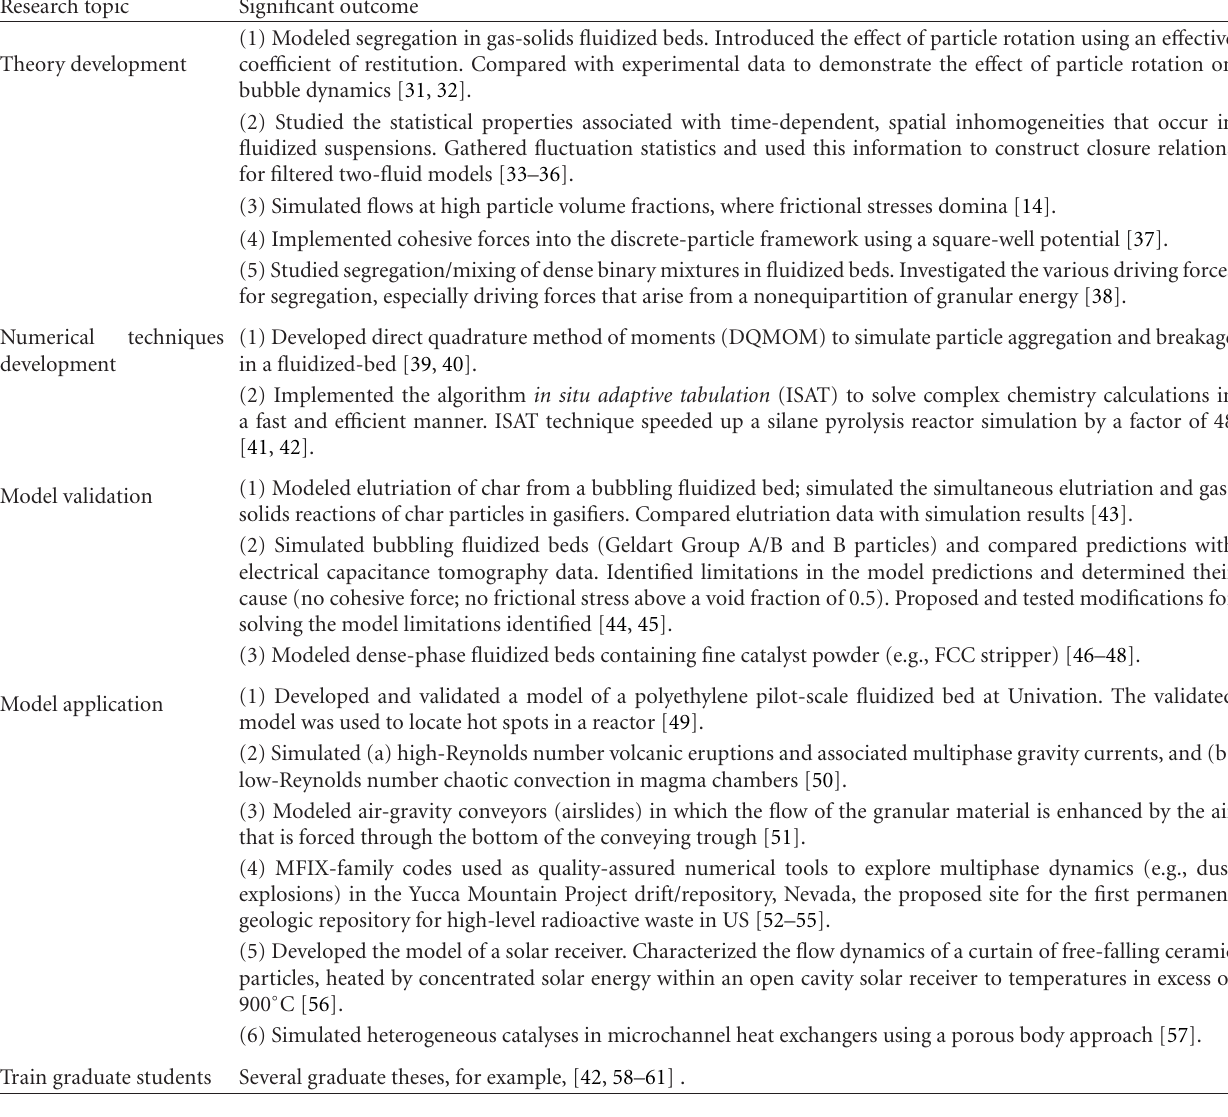
Table 1: Research topics and significant outcome.